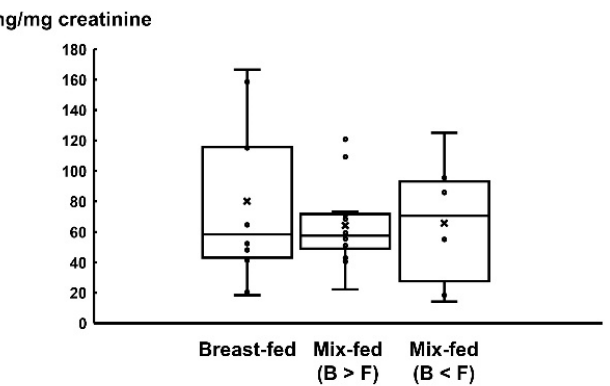
Figure 1. Urinary resistin level in breast-fed group, breast milk dominant mix-fed group, and formula milk dominant mix-fed group.